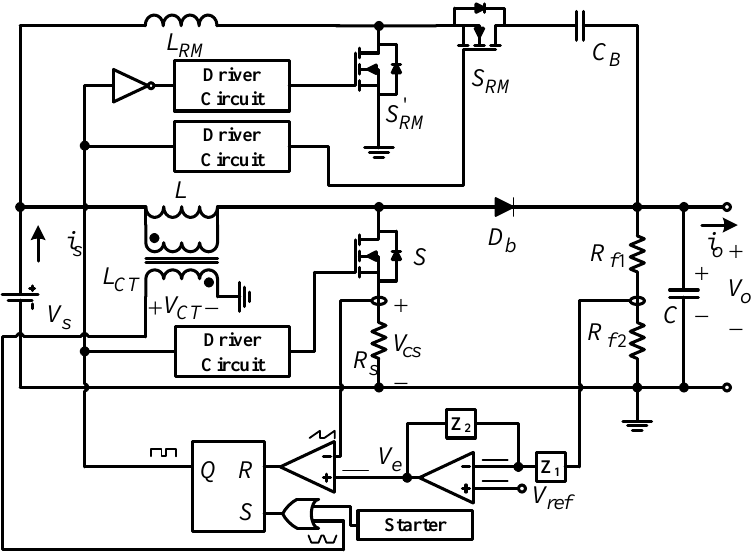
Figure 8. Realization diagram of the proposed boundary-mode control